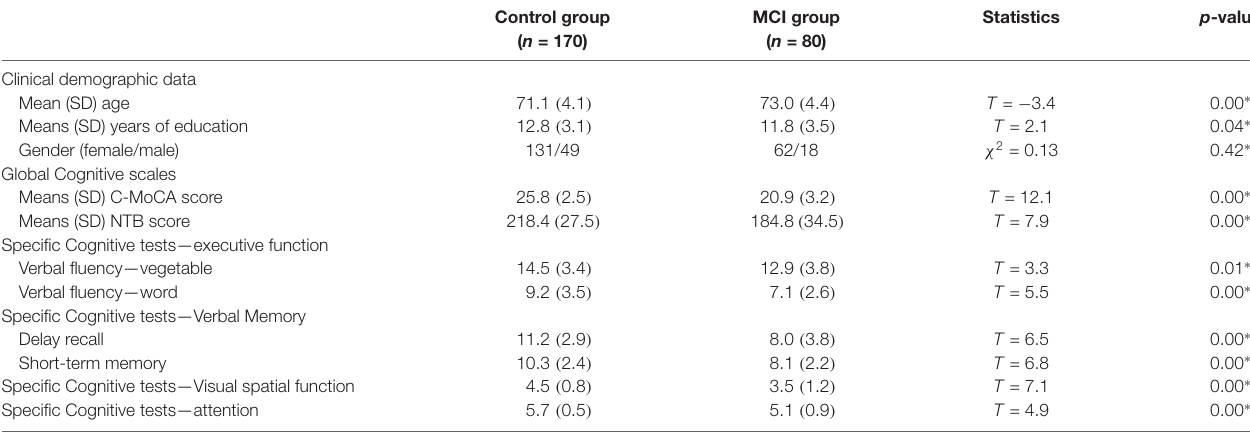
TABLE 1 | Between-group comparisons of age, years of education, and cognitive scores using independent sample t test and comparison of patient sex using Pearson’s χ 2 ± Fisher ’ s exact test.